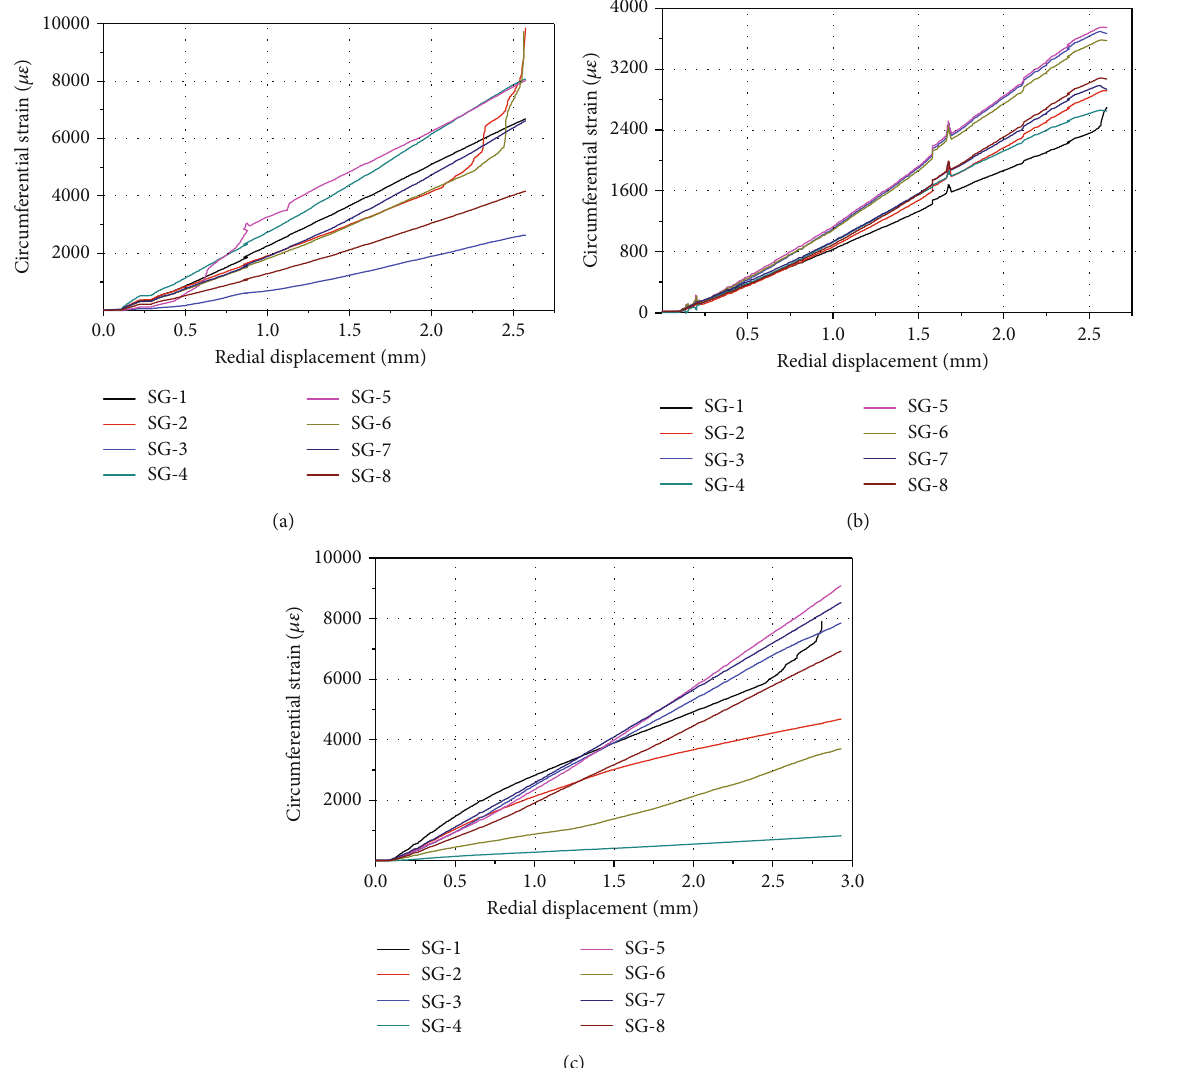
Figure 16: The circumferential strain-radial displacement curve of the test group with 1-layer prepreg wrap: (a) G-1-2 curve, (b) G-1-R-3 curve, and (c) G-1-2R-1